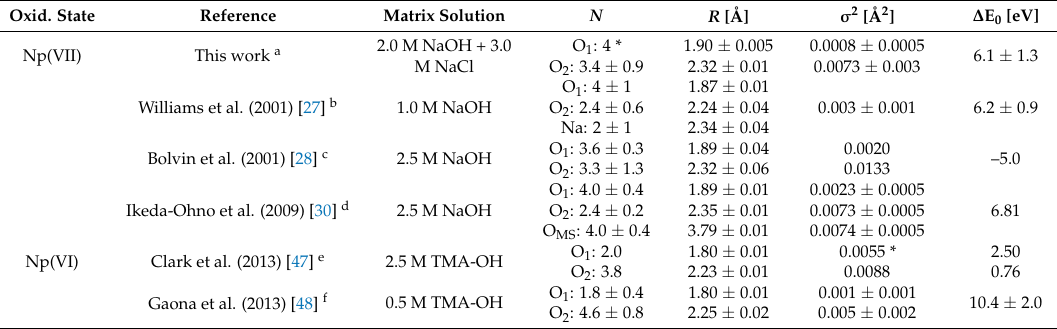
Table 2. Structural parameters determined for Np(VII) and Np(VI) aqueous species in hyperalkaline pH conditions, as obtained in this study and reported in the literature [27,28,30,47,48]. Oxid.